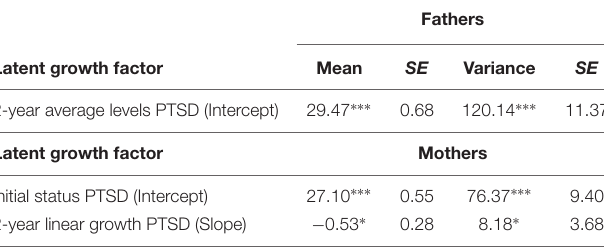
TABLE 2 | Latent variable means, variances, and standard errors for best-fitting 2-year unconditional growth model of PTSD symptoms by